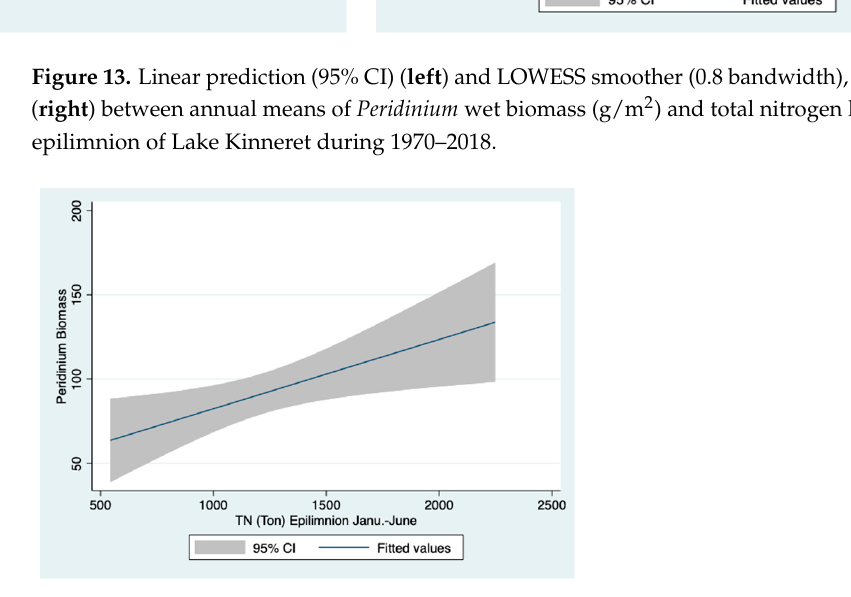
Figure 14. Linear prediction (95% CI) between winter and summer (January–June— Peridinium blooming season) of the means of Peridinium wet biomass (g/m 2 ) and total nitrogen loads (ton) in the epilimnion of Lake Kinneret during 1970–2018.